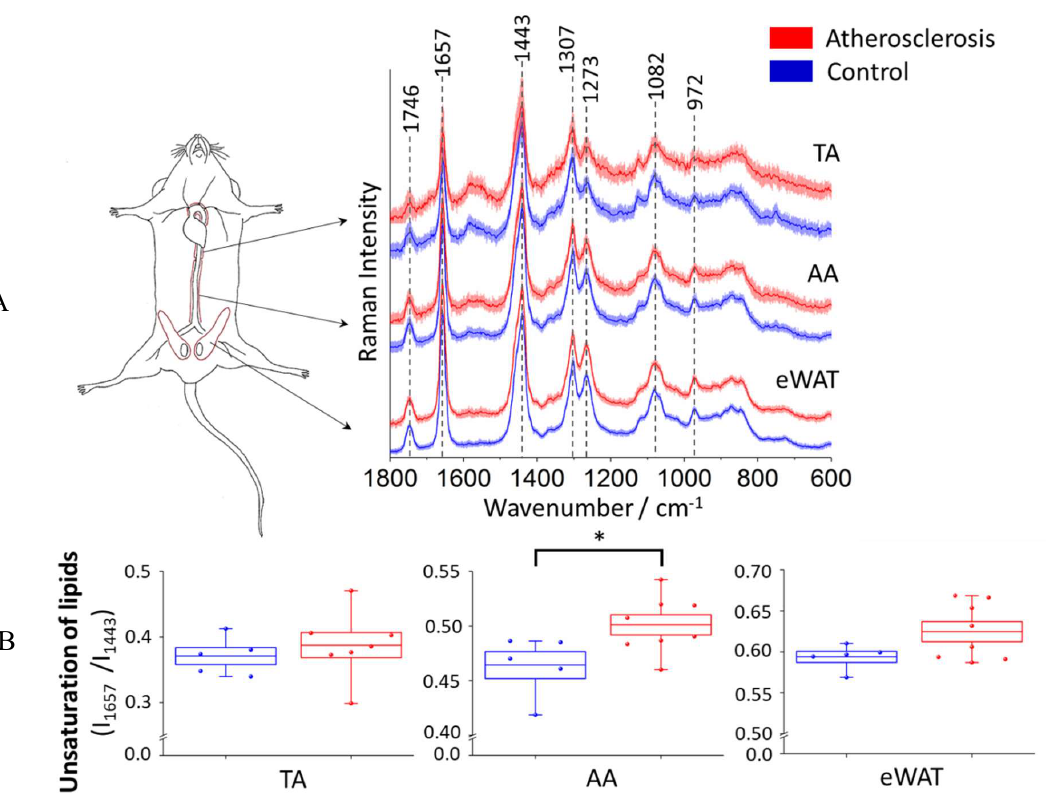
Figure 4. Averaged Raman spectra of the thoracic and abdominal PVAT and epididymal adipose tissue and statistical analysis of unsaturation of lipids. Averaged Raman spectra ( A ) in the fingerprint region of the thoracic (TA) and abdominal (AA) PVAT and the epididymal adipose tissue (eWAT) for the control group (blue) and animal with developed atherosclerosis (red) presented with the standard deviation on each data point. The analysis of the lipid unsaturation level ( B ) calculated as the ratio of integral intensities of bands at 1657 and 1443 cm − 1 . Values were shown in box plots: mean (horizontal line), SEM (box), minimal and maximal values (whiskers). The level of statistical significance: * p < 0.05.